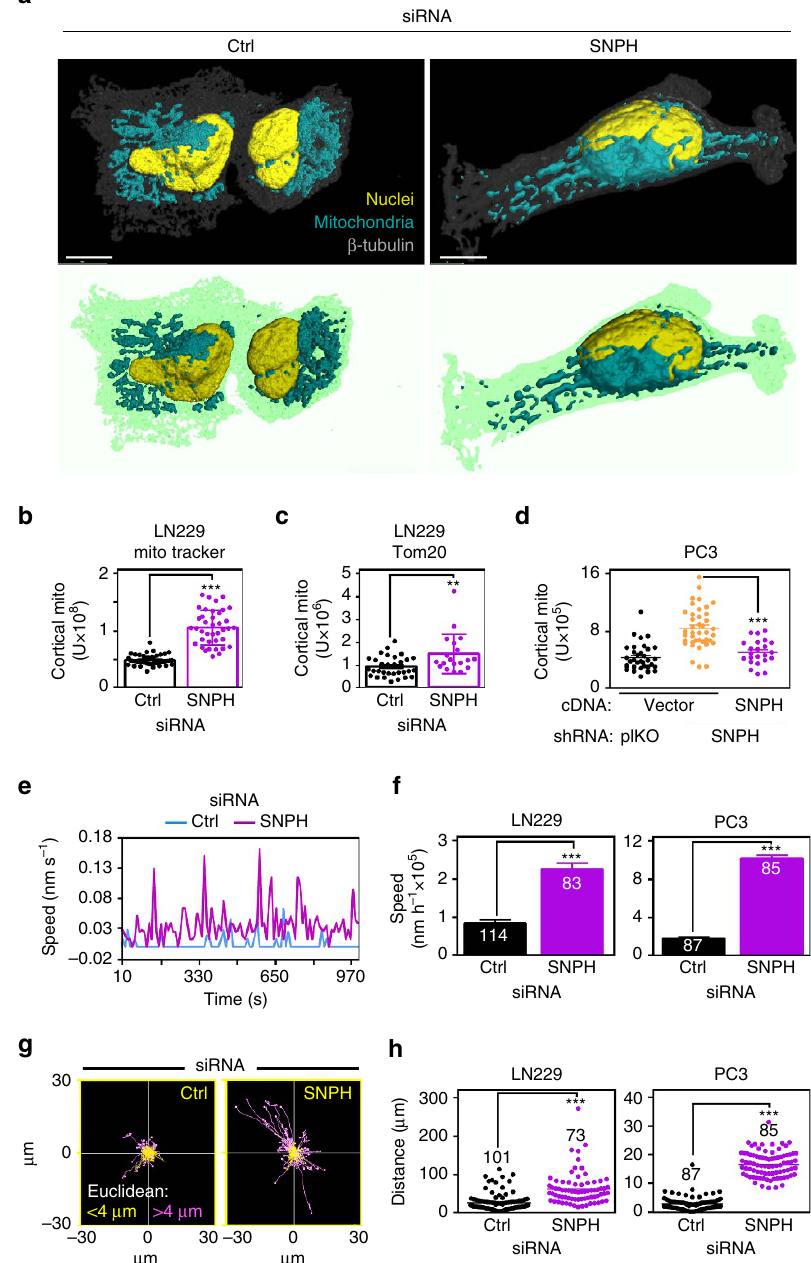
Figure 2 | Mitochondrial trafficking is modulated by SNPH. ( a ) LN229 cells transfected with control siRNA (Ctrl) or SNPH-directed siRNA were stained with antibodies against Tom20, b -tubulin and DAPI and analysed by confocal microscopy. Top, 3D rendering of mitochondria localization by fluorescence microscopy. Bottom, 3D drawings represent the cells above, and show mitochondrial repositioning to the cortical cytoskeleton. Scale bar, 10 m m. ( b , c ) Cells were labelled with MitoTracker ( b ) or Tom20 ( c ) and analysed for mitochondrial recruitment to the cortical cytoskeleton. Symbols correspond to individual cells. Data are represented as mean ± s.e.m. ** P ¼ 0.003; *** P o 0.0001 by Student’s t test. ( d ) PC3 cells transduced with the indicated shRNA were transfected with vector or shRNA-insensitive SNPH cDNA and analysed for mitochondrial trafficking to the cortical cytoskeleton. Symbols correspond to individual cells. *** P o 0.0001 by one-way ANOVA and Bonferroni’s post test. ( e , f ) Cells transfected with control or SNPH-directed siRNA and expressing mitochondria-targeted RFP were imaged by time lapse microscopy, and individual mitochondria were tracked through the stack to calculate trafficking parameters ( e ), and the speed of individual mitochondria per condition ( f ). Data are represented as mean ± s.e.m. ( n indicated on the individual bars). *** P o 0.0001 by Student’s t test. ( g , h ) The displacement of mitochondria relative to the initial location was calculated in 2D plots ( g ) and the distance travelled by individual mitochondria was quantified ( h ). Each tracing on g represents individual mitochondria and are colour coded according to Euclidean distance displacement. Each dot on h correspond to individual mitochondria ( n indicated in the individual panels). *** P o 0.0001 by Student’s t